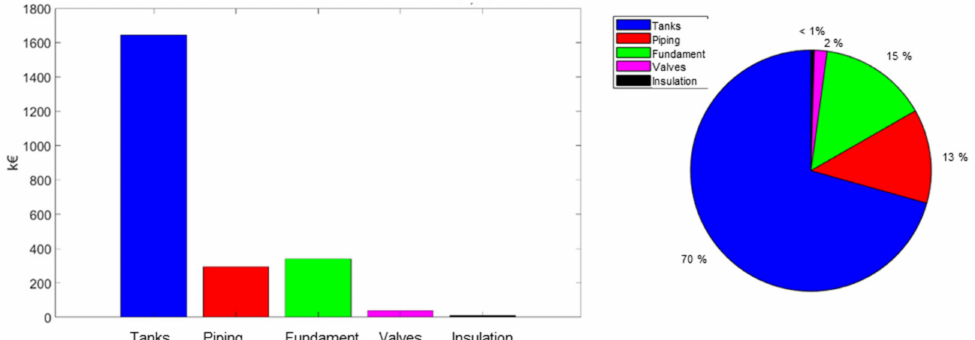
Figure 14. Cost of the entire storage system.